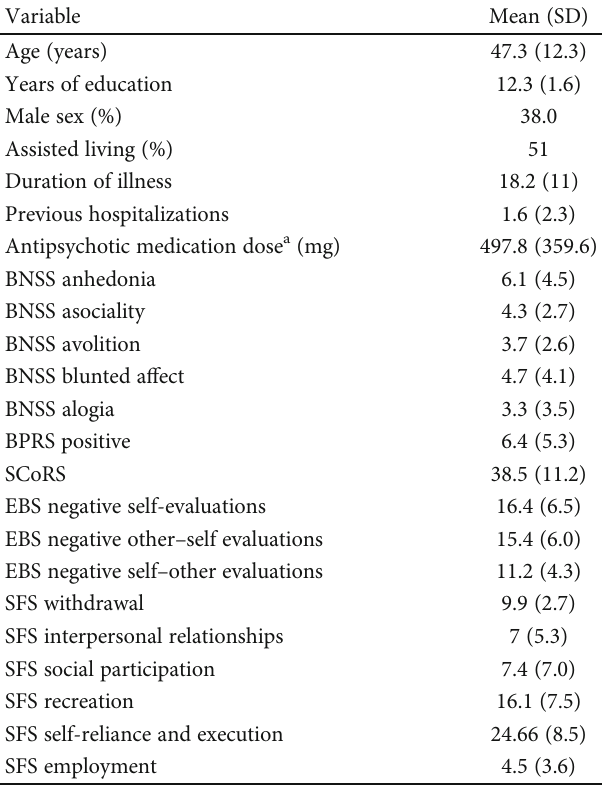
Table 1: Demographic